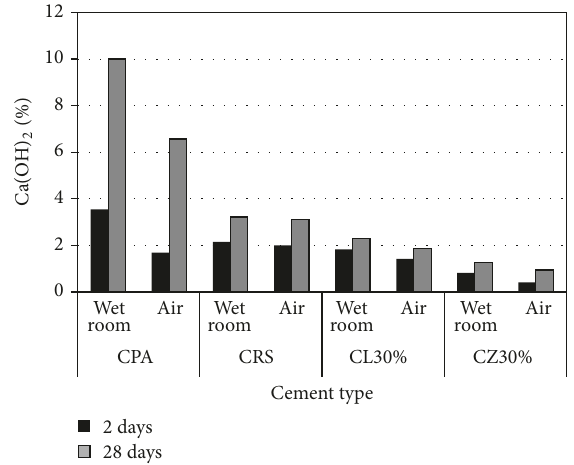
Figure11:Thecontentofportlanditeasafunctionofcuringmedium for all